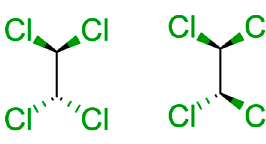
Figure 6. Structure of the two conformers of tetrachloroethane considered here: ( left ), conformer A and ( right ), conformer B. Table 6. Gibbs free energies (kcal/mol) for the formation of buckycatcher fullerene complexes according to several semi-empirical methods in gas and with several solvation models. Conformer averaged data with the conformational entropy considered. Structures of conformers in Figure